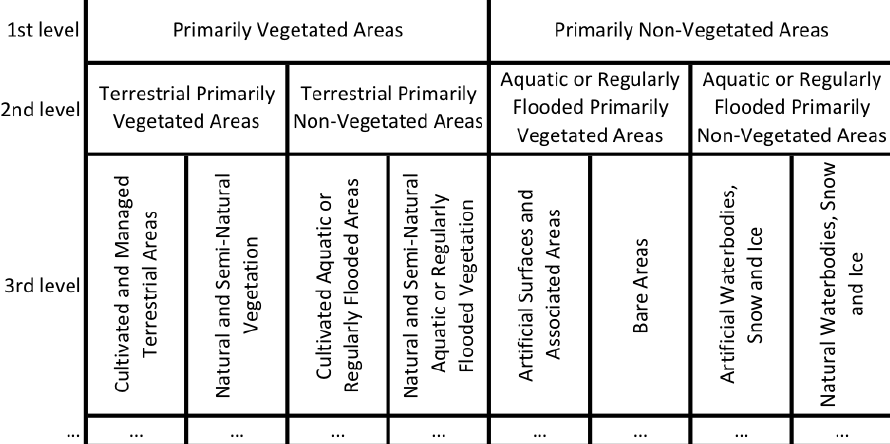
Figure 1. The three upper level categories in the land cover classification system (LCCS)